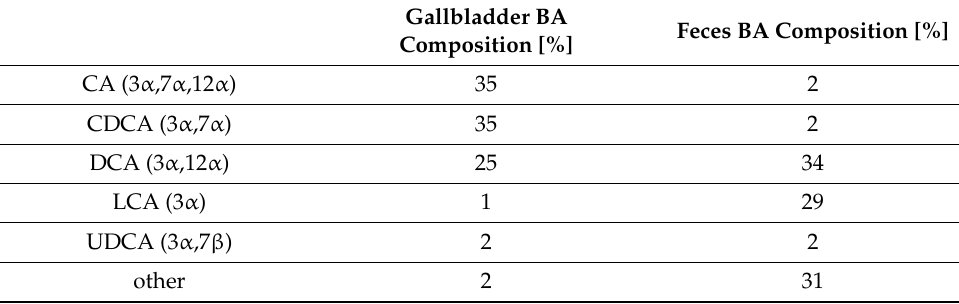
Table 1. Relative composition of bile acids in gallbladder and